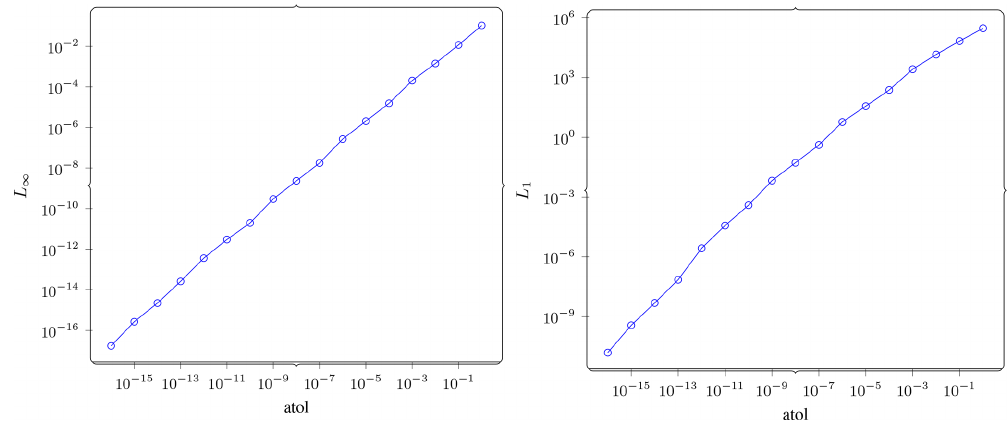
Figure A1. Direct compression. On the left, L ∞ norm of error vs. atol is shown. This plot verifies that ZFP respects the tolerance we set. On the right, L 1 norm of error vs. atol is shown. From the difference in magnitude between the L ∞ plot and this one, we can see how the error is spread across the domain.